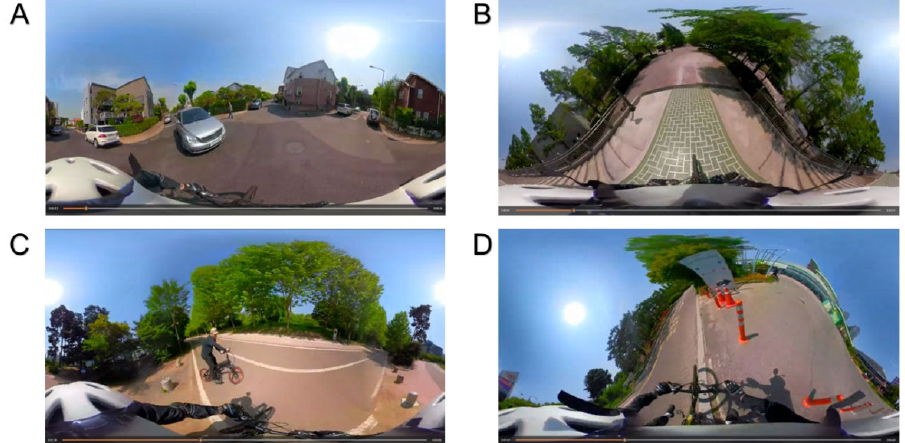
Figure 2. Example captures of virtual reality videos. ( A ) other vehicle accident, ( B ) accident in a downhill road, ( C ) other bicycle accident, ( D ) accident by the curbside. The awareness phase began with a 30 ‐ min lecture. The purpose of the lecture was not to impart information such as traffic signs or cycling skills but to encourage students to assess related information to facilitate their engagement. Students then searched the in ‐ ternet to identify risk factors and discussed how to distinguish between environmental